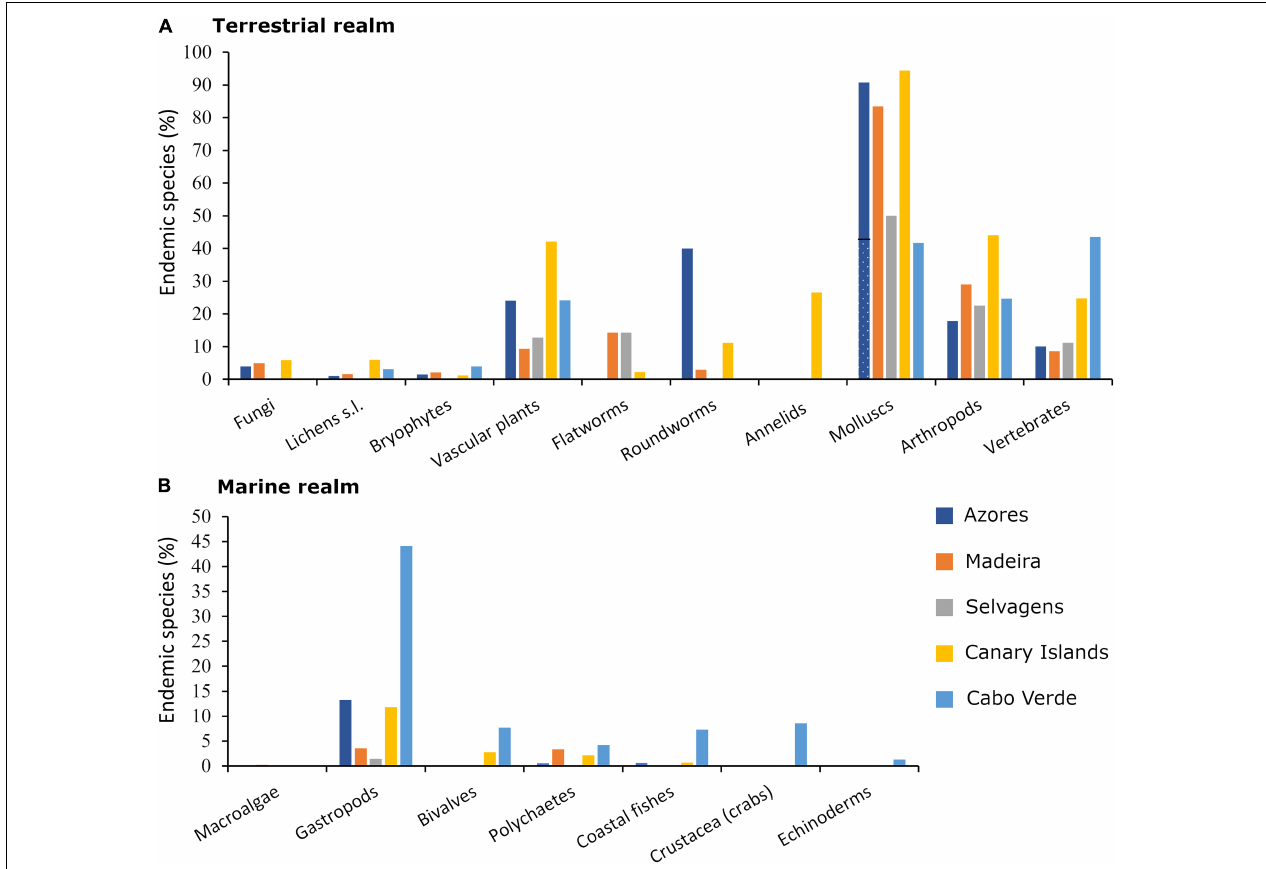
FIGURE 2 | Percentage of native species of several taxonomic groups that are endemic species of each Macaronesian archipelago (Azores, Madeira, Selvagens, Canary Islands, and Cabo Verde) at (A) the terrestrial and (B) the marine realms. Information on the terrestrial biota was extracted from Arechavaleta et al. (2005), Borges et al. (2008, 2010), Miralles et al. (2011), Vasconcelos et al. (2012b, 2020), and Biodiversity Data Bank of the Canary Islands (2021). Data on marine taxa was extracted from Freitas et al. (2019) and Neto et al. (2021a,b,c), and unpublished data from one of the authors (Ávila, S.P.) regarding bivalves. The proportion of the endemic species was calculated over the number of native species, which included those considered probably or possibly native. Only extant species and breeding birds were considered. Lichens s.l. includes lichenicolous fungi, Vascular plants include Spermatophyta, ferns, and fern allies, Arthropods include Tardigrada, and Crustacea only refers Brachyura (crabs). The dotted area in the bar of the Azorean Molluscs indicates the existence of some uncertainty regarding the proportion of endemic species (43–91%; Frias Martins, A., pers. comm). In the case of Madeira, we have considered 25 additional species that have recently been classified as native based on fossil evidence; Teixeira, D., pers. comm.). Diatoms and amoebae are not represented because of their incomplete information. Also, Platyhelminthes (flatworms) and Annelids show the same value in Madeira and Selvagens because the source literature does not discriminate between the two archipelagos. No data was reported for the Platyhelminthes, Nematoda (roundworms) and Annelida in Cabo Verde, and for Nematoda and crustaceans Brachyura (crabs) in Selvagens (see ESM1 in Supplementary Material for detailed